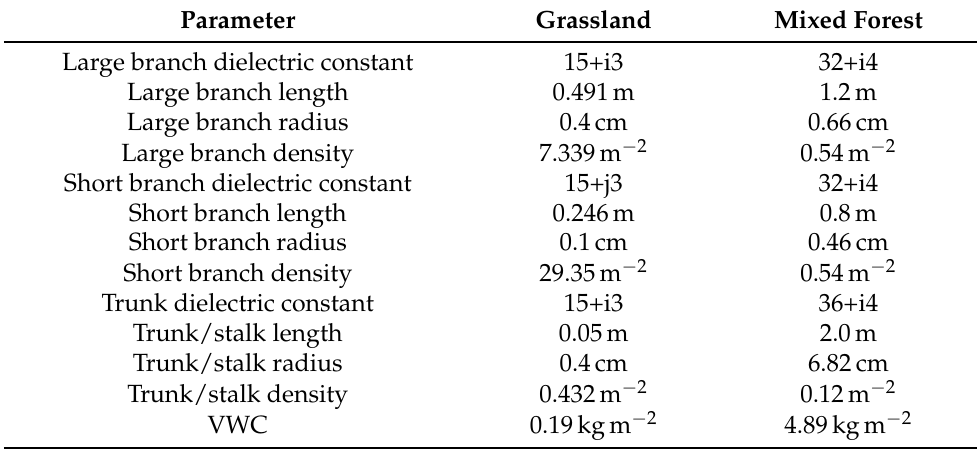
Table 1. Vegetation parameters chosen for grassland (IGBP: 5) and mixed forest (IGBP: 10) land covers [40,41]. These parameters are inputs to the SSBM except